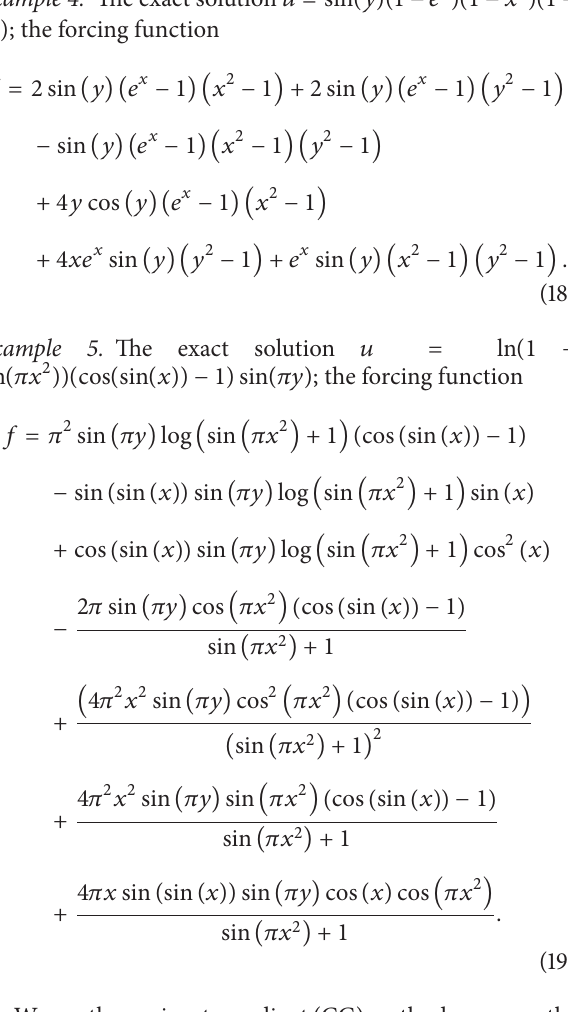
Example 4. The exact solution 𝑢 = sin (𝑦)(1 − 𝑒 𝑥 )(1 − 𝑥 2 )(1 − 𝑦 2 ) ; the forcing function